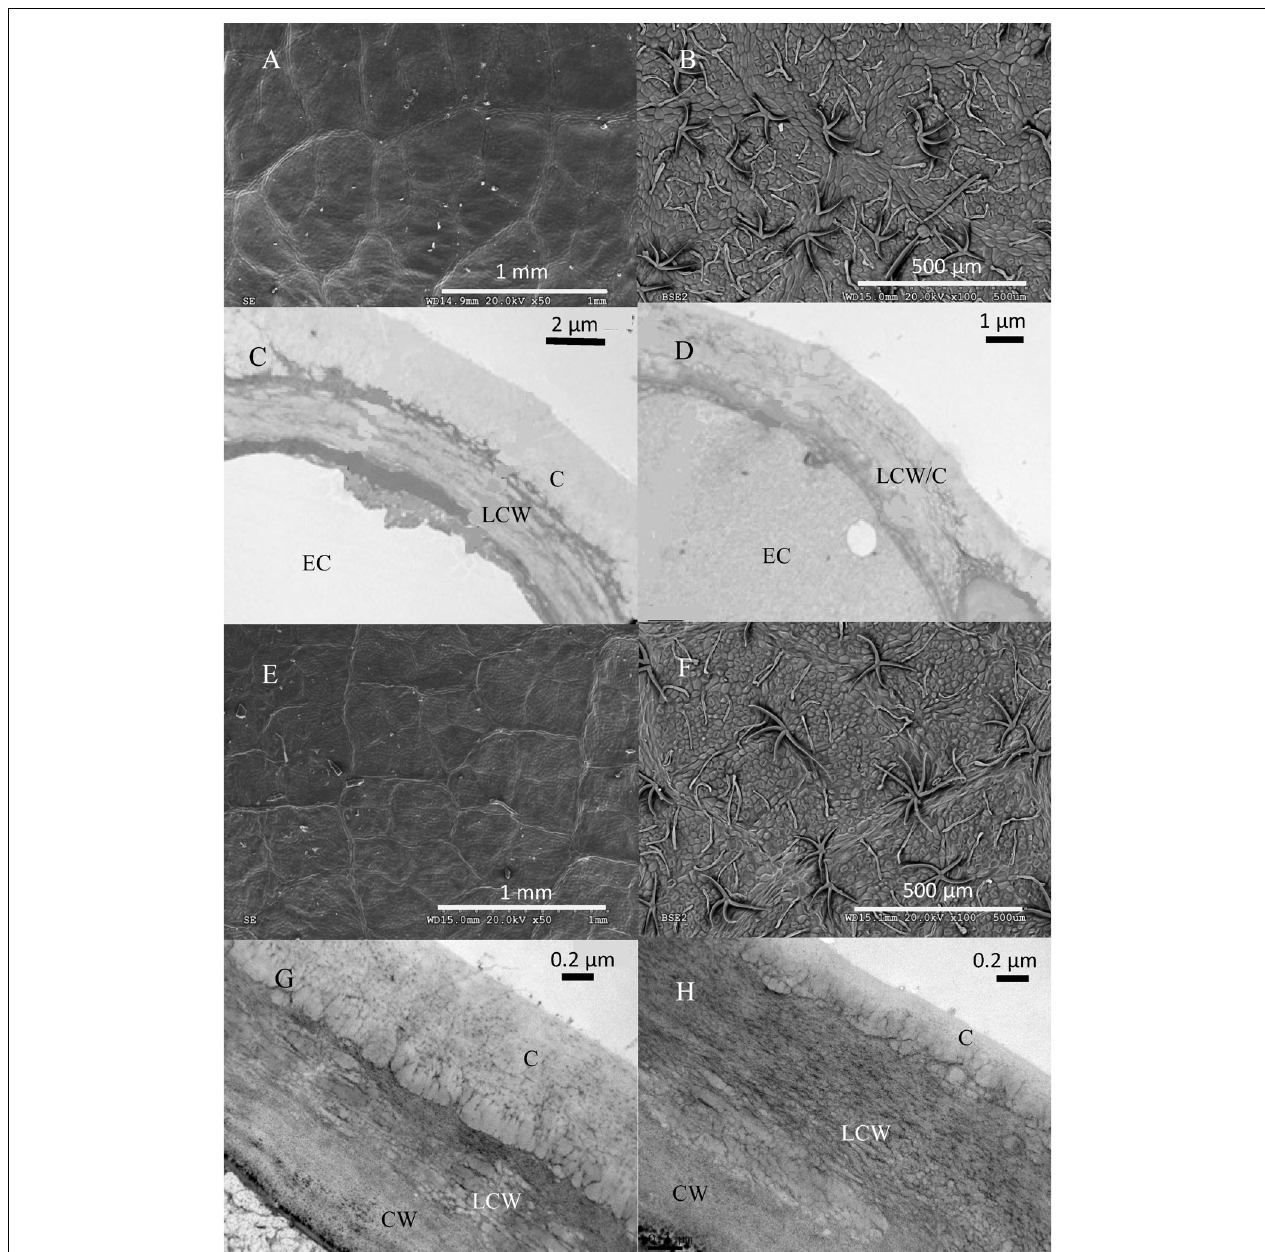
FIGURE 4 | Electron micrographs of adaxial and abaxial sessile oak leaf surfaces. SEM images correspond to: (A) adaxial surface of an upper canopy leaf, (B) abaxial upper canopy leaf, (E) adaxial surface of a lower canopy leaf, (F) abaxial surface of a lower canopy leaf. TEM micrographs correspond to: (C) adaxial epidermis of an upper canopy leaf, (D) abaxial epidermis of an upper canopy leaf, (G) adaxial epidermis on a lower canopy leaf, (H) abaxial epidermis of a lower canopy